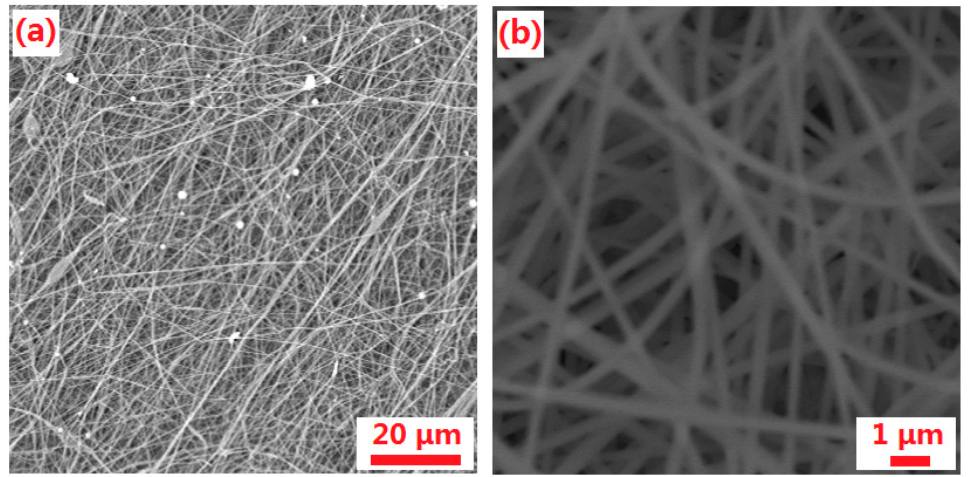
Figure 5. ( a , b ) SEM images of the PAN-nanofiber with different magnification.